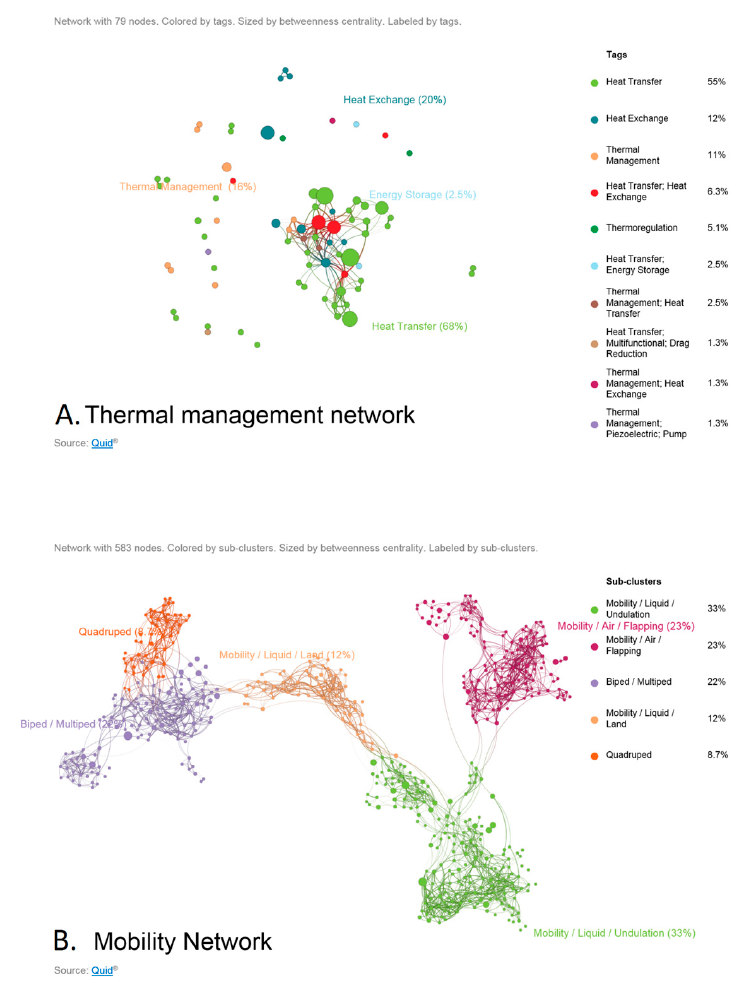
Figure 10. A comparison between the use of bio-inspired design in the fields of mobility and thermal management. ( A ) Thermal management network. ( B ) Mobility network.